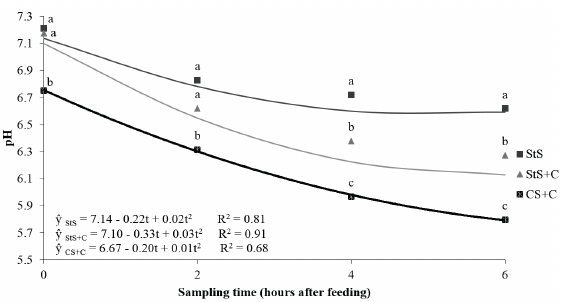
Figure 1 - Ruminal pH as a function of sampling time of sheep fed Stylosanthes silage without concentrate (StS), Stylosanthes silage with concentrate (StS+C), and corn silage with concentrate (CS+C). Different letter in the points are significantly based on a Tukey-test (P<0.05). Effects of diets (P<0.01), time (P <0.01) and interaction (P =0.04); standard error of mean (0.05).